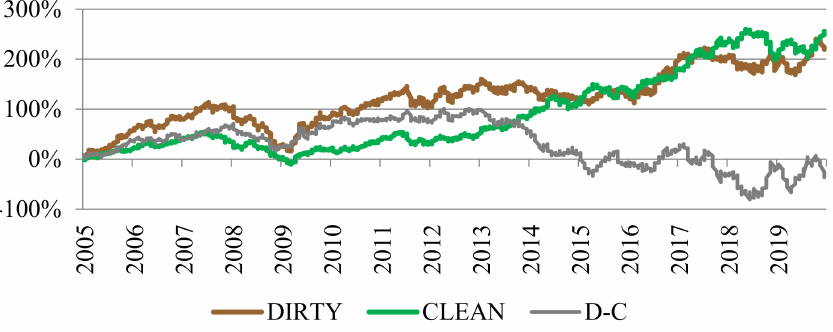
Figure 2. Cumulative rate of return on DIRTY and CLEAN portfolios between 2005–2019.